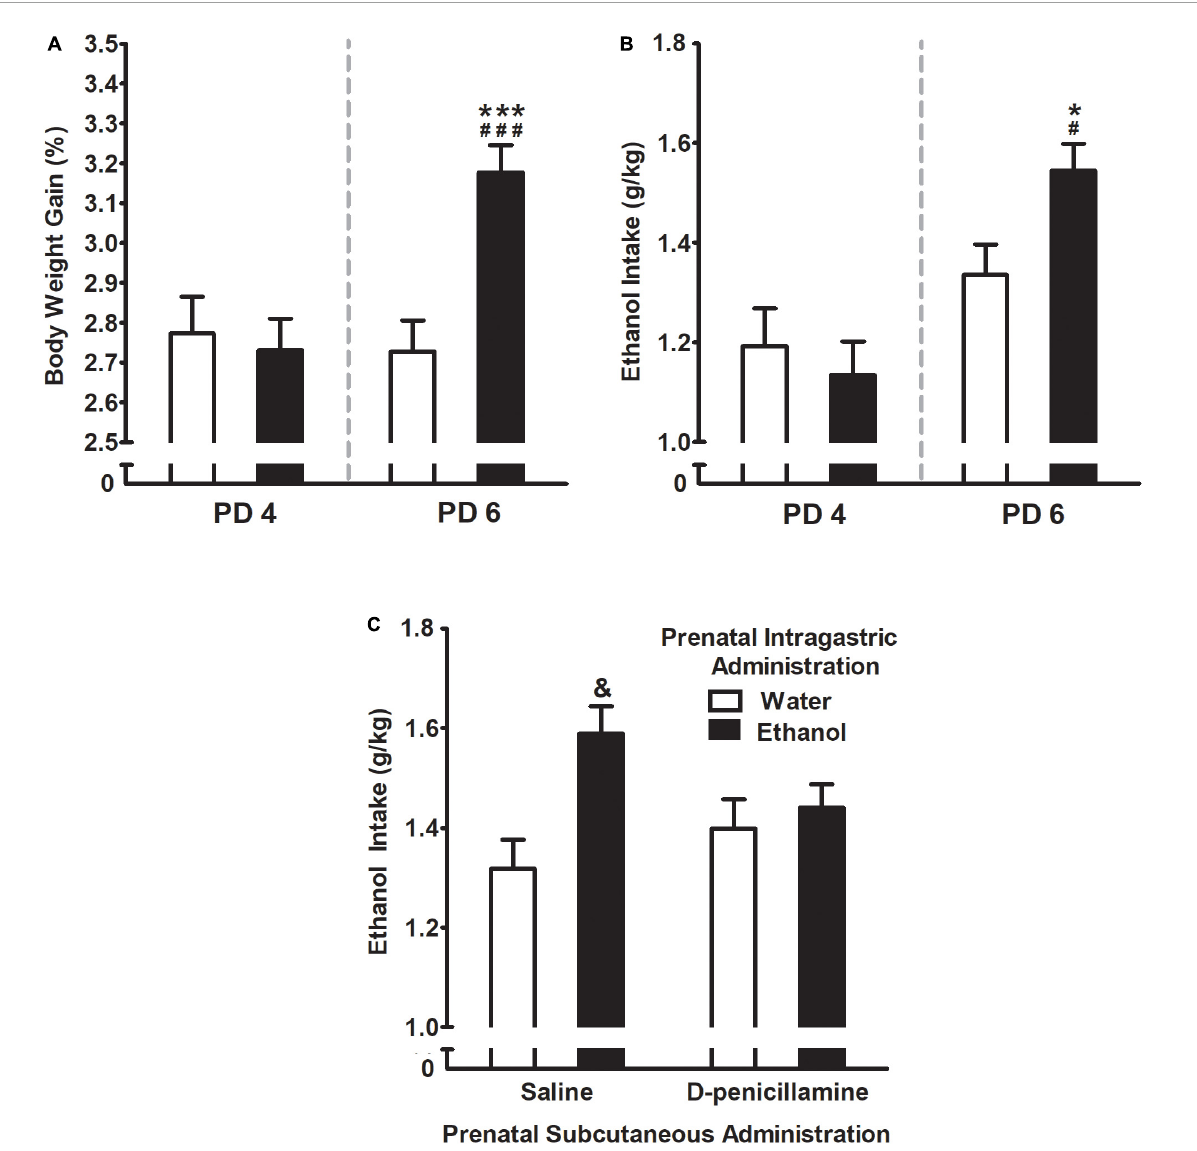
FIGURE4 (A) Percent body weight gain and (B) ethanol intake (g/kg) as a function of prenatal intragastric administration of ethanol (black) or water (white), and postnatal days of assessment (PDs 4 and 6). ### p < 0.001, # p < 0.05 indicates that values at PD6 are significantly different from PD 4 in the group of pups prenatally exposed to ethanol. *** p < 0.001, * p < 0.05 indicate the difference between the group exposed to ethanol relative to water group at PD6. (C) Ethanol intake (g/kg) as a function of prenatal intragastric and subcutaneous administration. & p < 0.05 indicates pups prenatally exposed to ethanol are different from all groups. Vertical lines illustrate standard errors of the mean